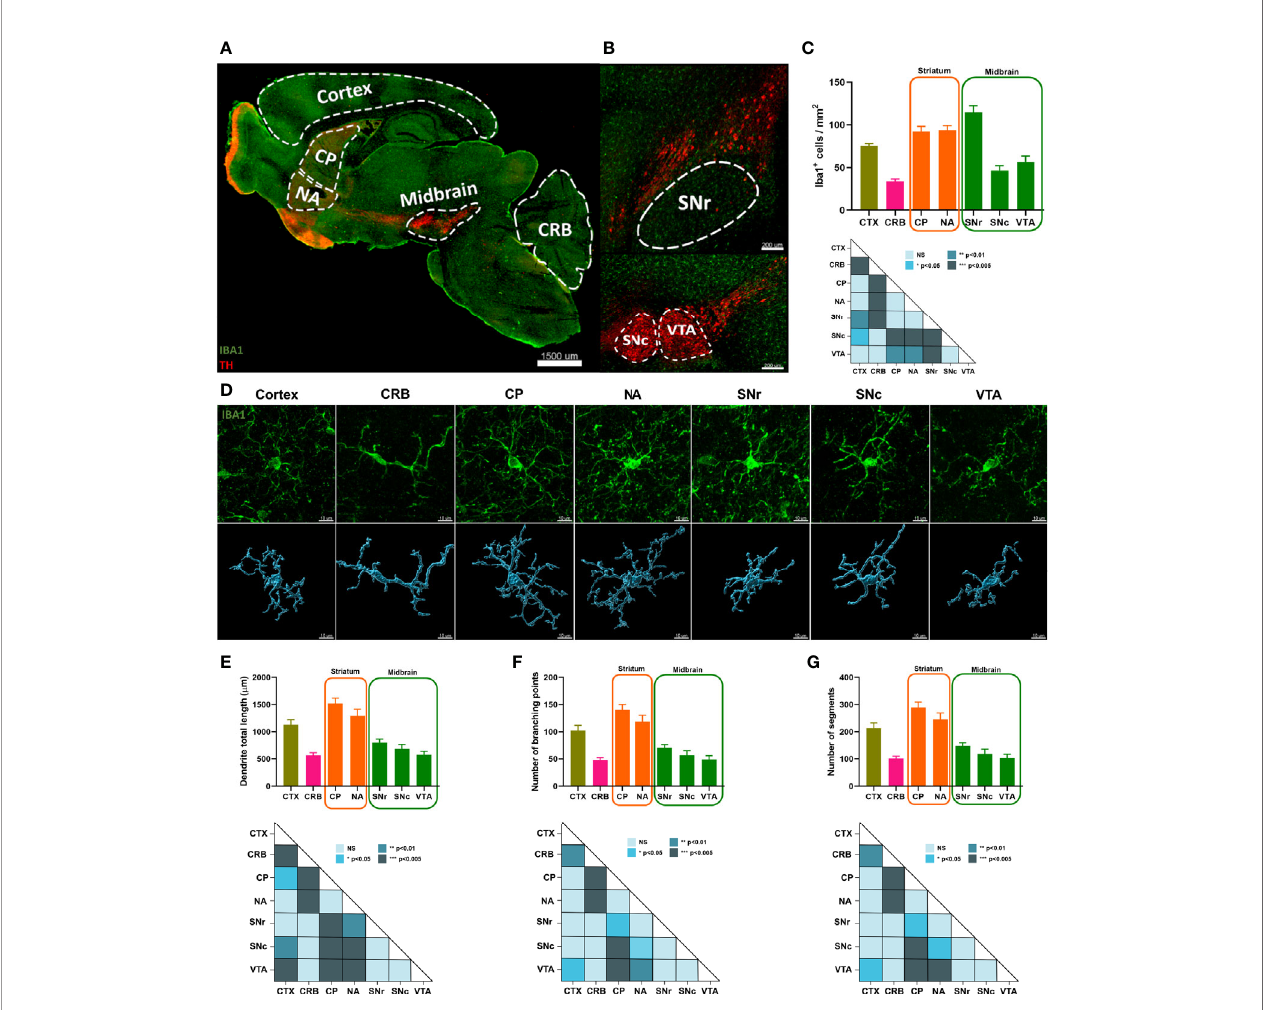
FIGURE 4 | Microglial density and morphology across striatum and midbrain are heterogeneous. (A) Representation of different areas analyzed for microglia density and morphology. TH was employed to identify the brain regions, while IBA1 was used to visualize microglia. Scale bar, 1500 µm (CP, caudoputamen; NA, nucleus accumbens; CRB, cerebellum). (B) Tile pictures showing midbrain sub-regions in sagittal mouse brain. Scale bar, 200 µm (SNr, substantia nigra pars reticulata; SNc; substantia nigra pars compacta; VTA, ventral tegmental area). (C) Quanti fi cation of microglial cell density in the different brain areas, cortex (in pale green), cerebellum (in pink), striatum (in orange) and midbrain (in green). Bars represent the mean ± standard error of the mean (SEM) from four independent mice. One-way ANOVA with post-hoc Tukey ’ s test was used for statistical test (*p < 0.05, **p < 0.01, ***p < 0.005). (D) 3D reconstruction of representative microglial cells across different brain regions. Scale bar, 10 m m (CRB, cerebellum; CP caudoputamen; NA, nucleus accumbens; SNr, substantia nigra pars reticulata; SNc, substantia nigra pars compacta; VTA, ventral tegmental area). (E-G) Quanti fi cation of microglial cell complexity across brain regions. Bars represent the mean ± standard error of the mean (SEM) from twelve independent Iba1+ cells. One-way ANOVA with post-hoc Tukey ’ s test was used for statistical test for process total length, whereas Kruskal-Wallis followed by post-hoc Dunn ’ s test was used as statistical test for number of branching points and number of segments (NS not signi fi cant, *p < 0.05, **p < 0.01, ***p < 0.005) ( Table S5 ). CTX, cortex; CRB, cerebellum; CP caudoputamen; NA, nucleus accumbens; SNr, substantia nigra pars reticulata; SNc, substantia nigra pars compacta; VTA, ventral tegmental